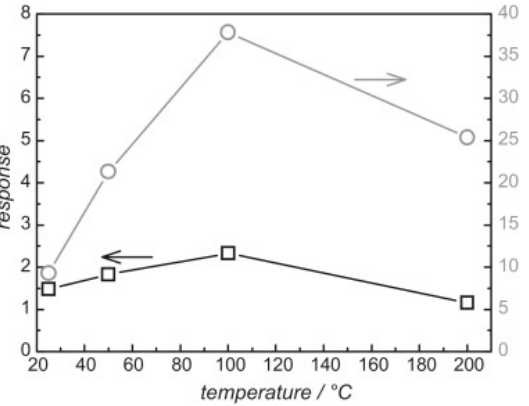
Figure 41. Response towards 5 ppm NO 2 in dry synthetic air with UV light irradiation at different temperatures of the non-structured ( black ) and the mesoporous In 2 O 3 ( gray ). Reproduced with permission from [68].